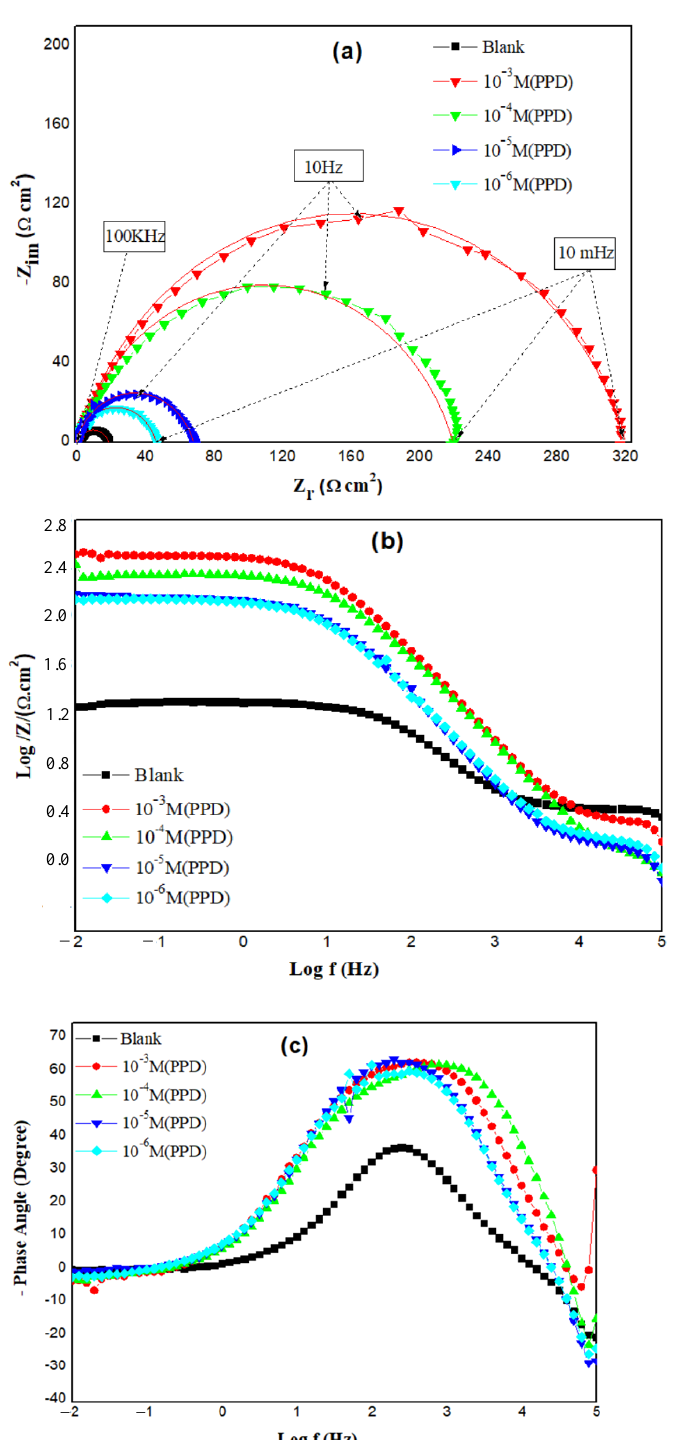
Figure 3. ( a ) Nyquist plots, ( b ) Bode-module plots, ( c ) Bode-phase plots of MS/HCl electrochemical system containing various PPD concentrations.